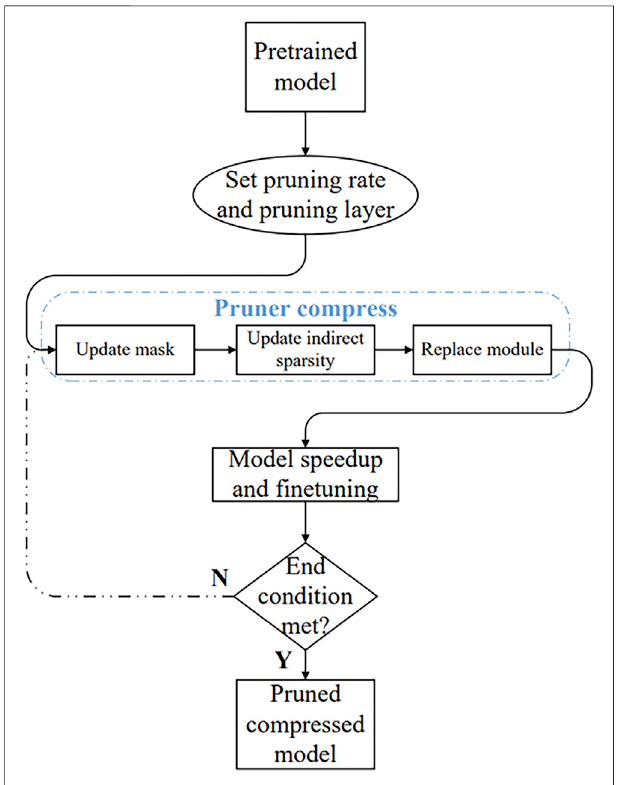
FIGURE 3 | Structured pruning fl ow